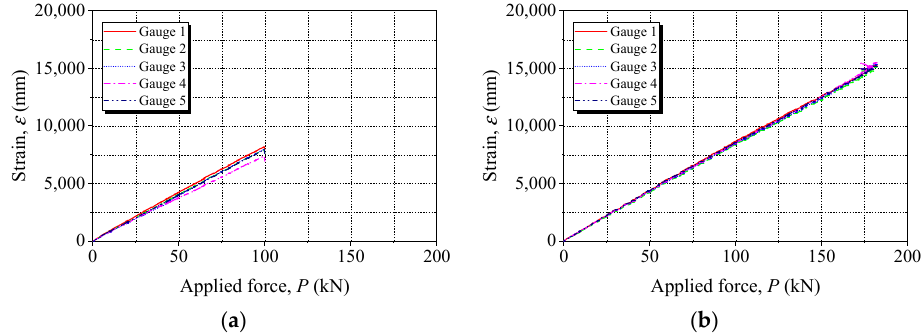
Figure 8. Tensile response curves of anchored CFRP laminates after 144-h energization. ( a ) C-144. ( b ) W-144.